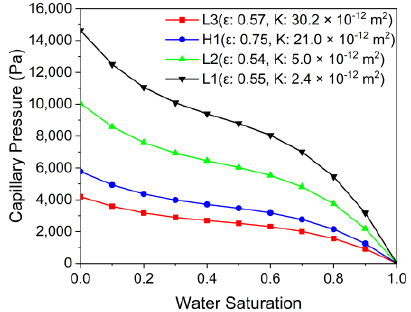
Figure 14. Capillary pressure saturation curves calculated as the Leverett J-function from 0 to 1 at every water saturation of 0.1 by the PTL types.